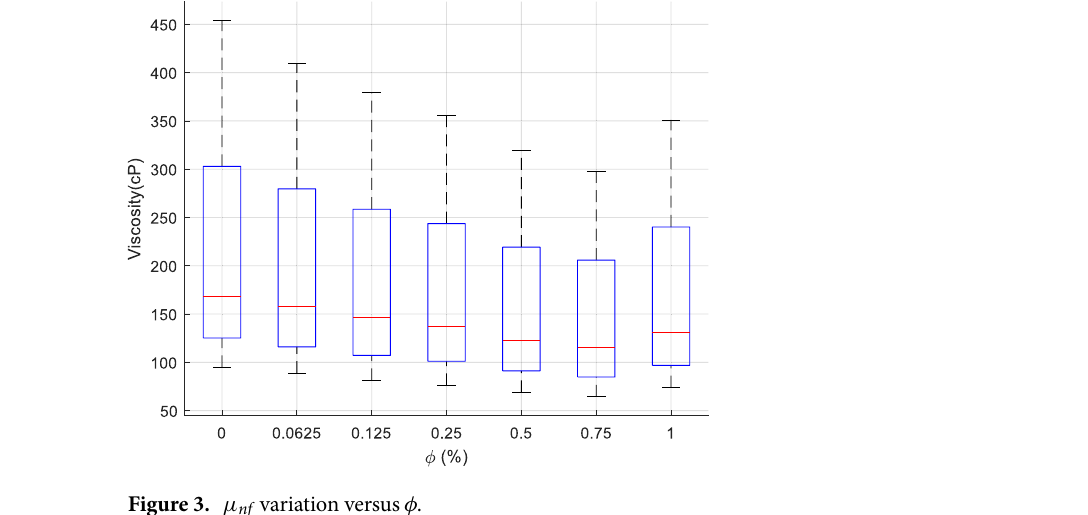
Figure 3. µ nf variation versus φ .